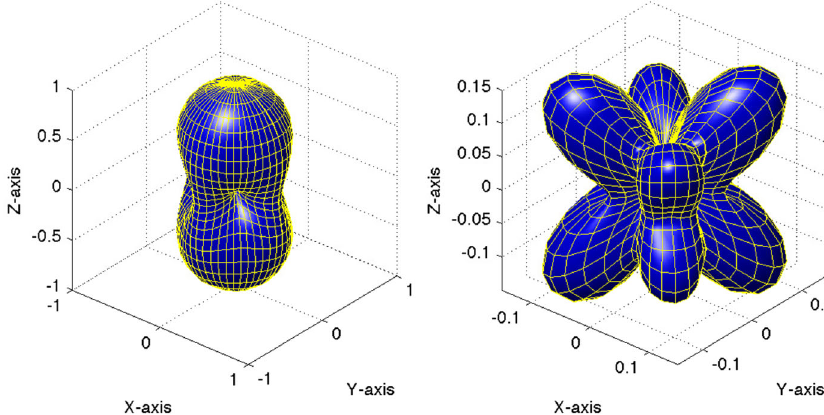
Fig. 30 Antenna pattern for Michelson interferometer strain response to unpolarized gravitational waves evaluated in the small-antenna limit, f = 0 ( left plot ) and at the free-spectral range frequency, f = c /( 2 L ) ( right plot ). The interferometer arms point in the ˆ x and ˆ y directions. Note the change in the scale of the axes between the two plots